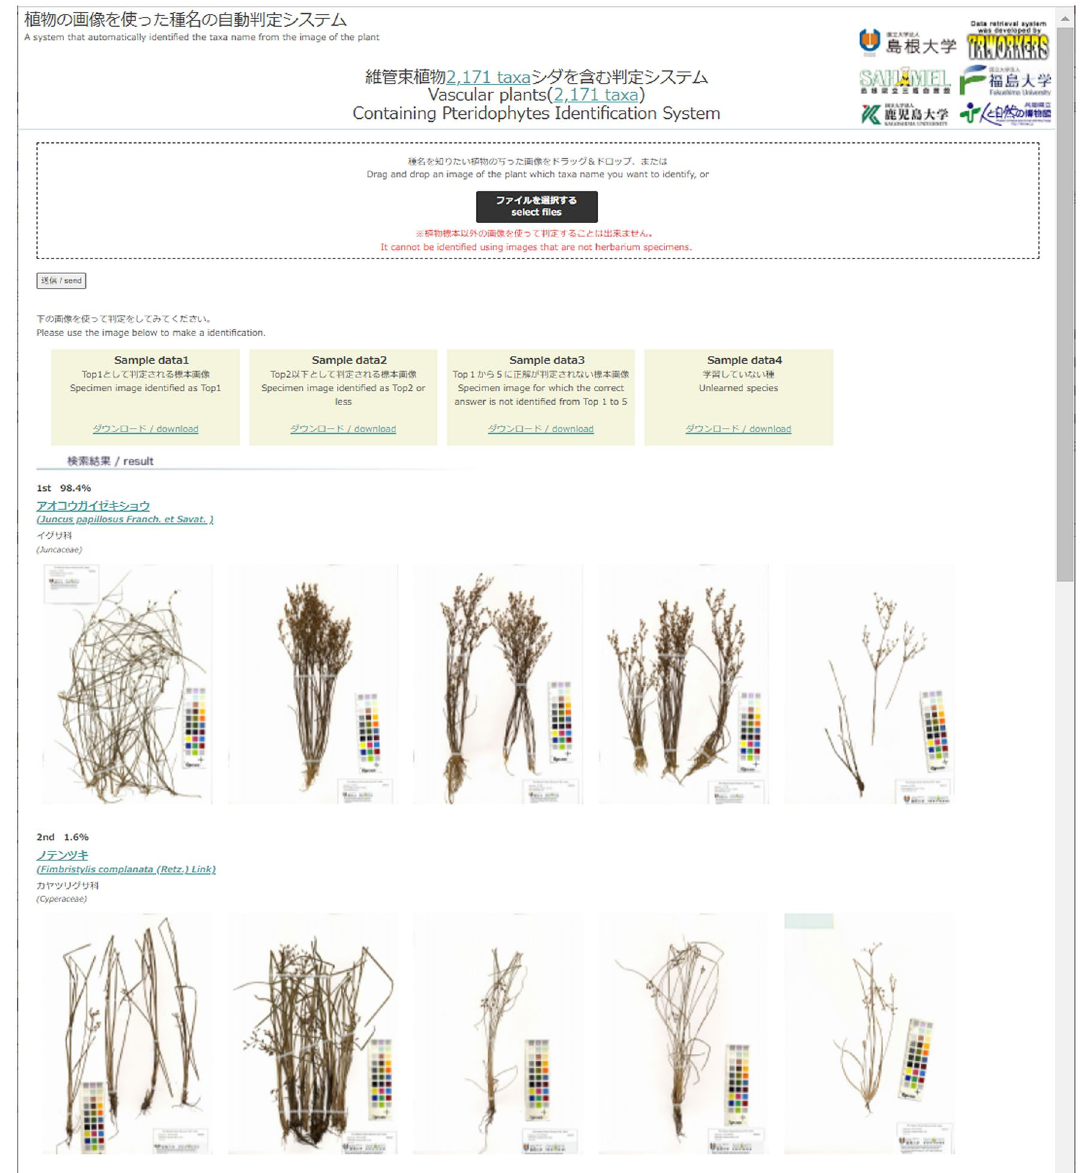
Figure 6. A system that automatically identified the taxa name from an image of a plant (http:// tayou sei. life. shima ne-u. ac. jp/ ai/ index_ all. php). The identification system for pteridophytes is located at http:// tayou sei. life. shima ne-u. ac. jp/ ai/ index_ Pteri dophy tes. php. Drag and drop an image of the plant for which you want to identify the taxa name, or select files and click the send button. Plant taxa from Top-1 to Top-5 are displayed as candidates, and the accuracy is also